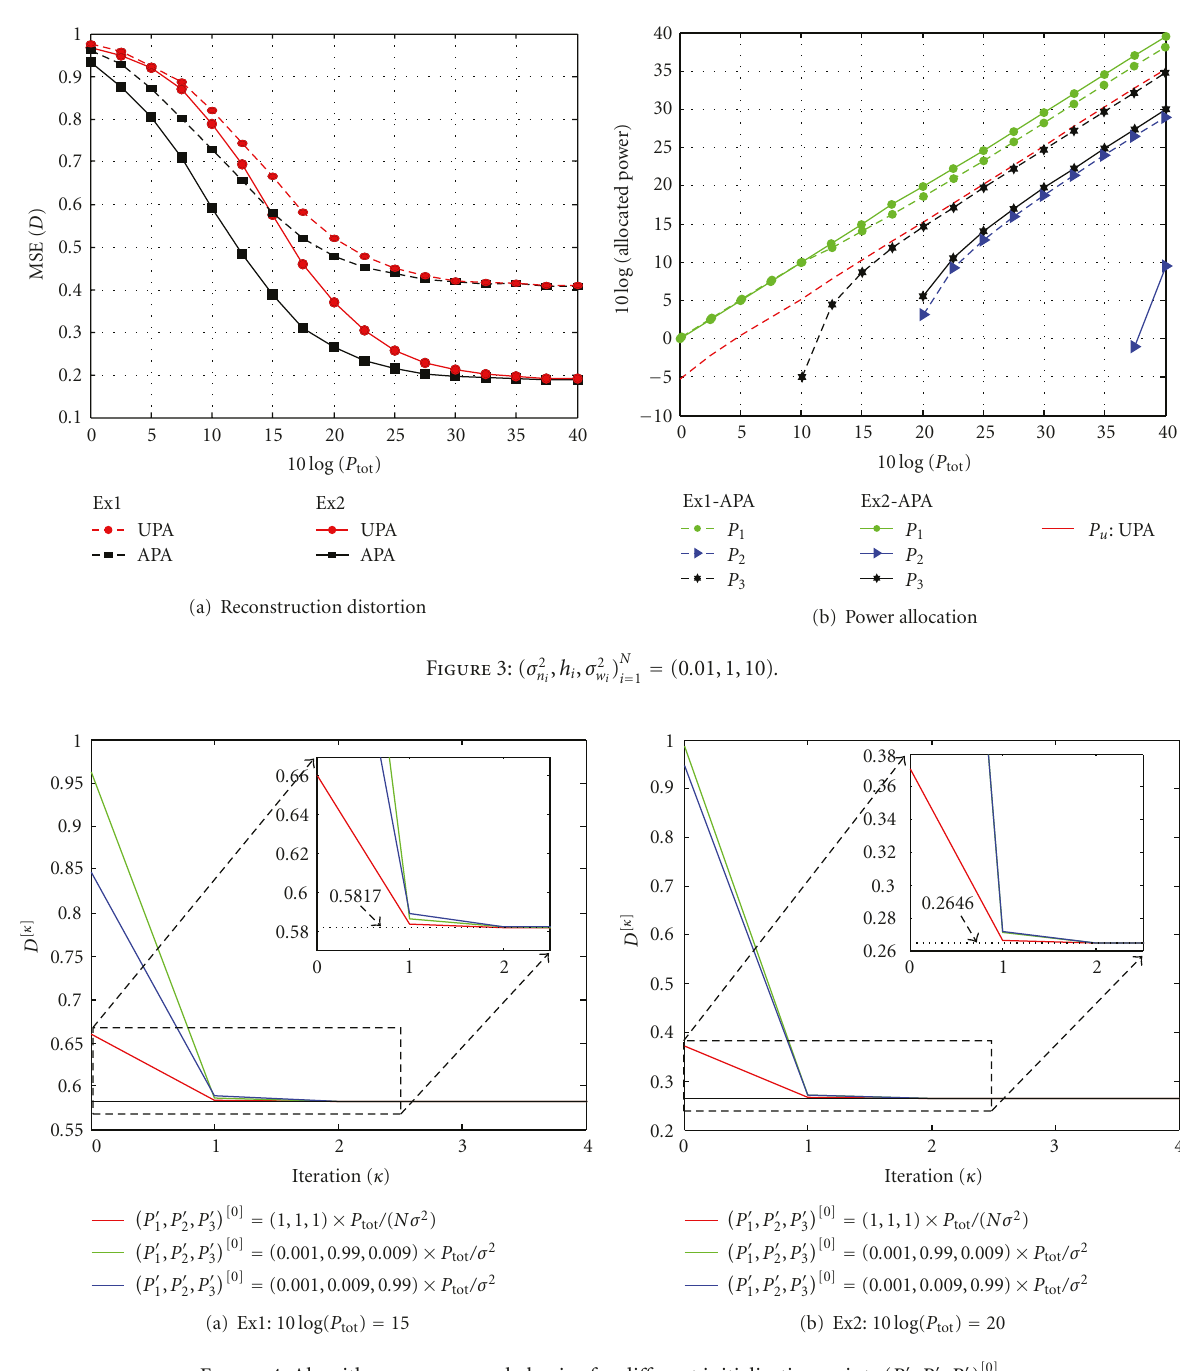
Figure 4: Algorithm convergence behavior for di ff erent initialization points ( P (cid:3) 1 , P (cid:3) 2 , P (cid:3) 3 ) [0]